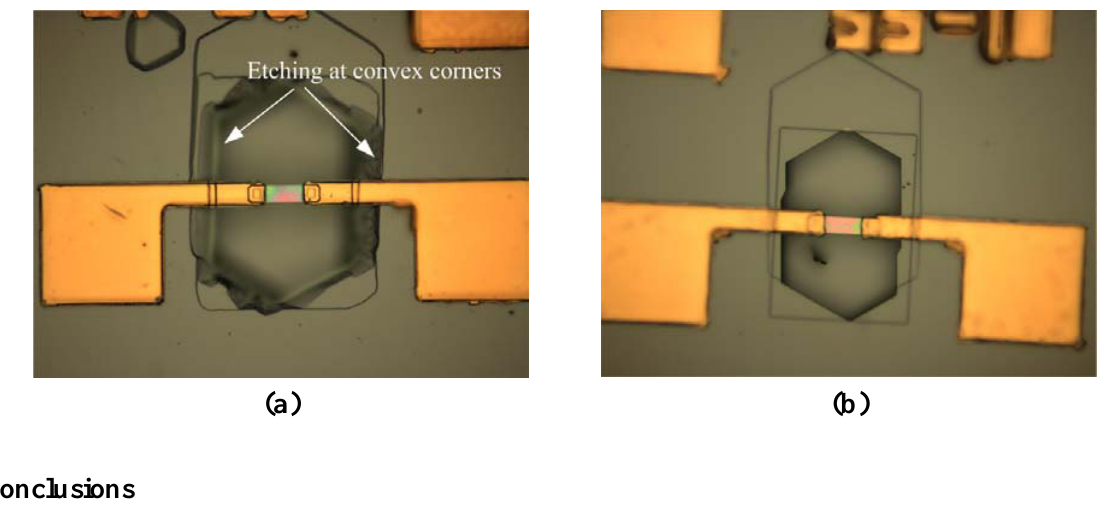
Figure 7. (a) The picture of a submicron beam after 1 hour etching in TMAH after layer. (b) The picture of a sample without TMAH etching after stripping stripping the SiO 2 the SiO 2